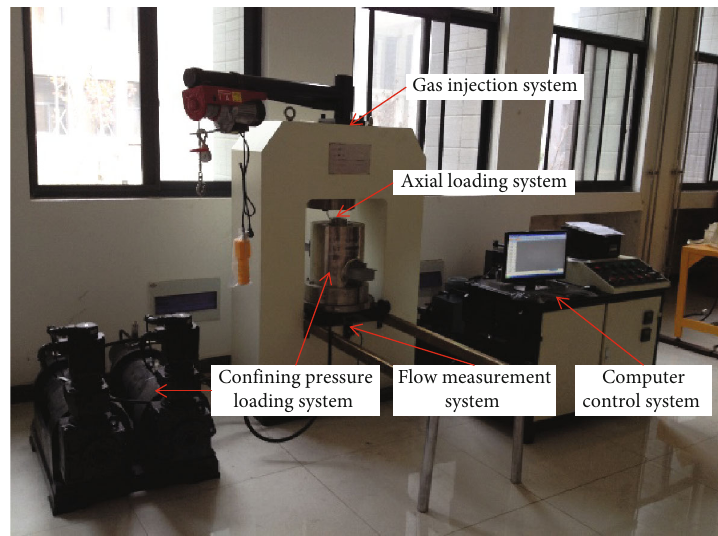
Figure 1: Three-axis servo seepage testing machine.